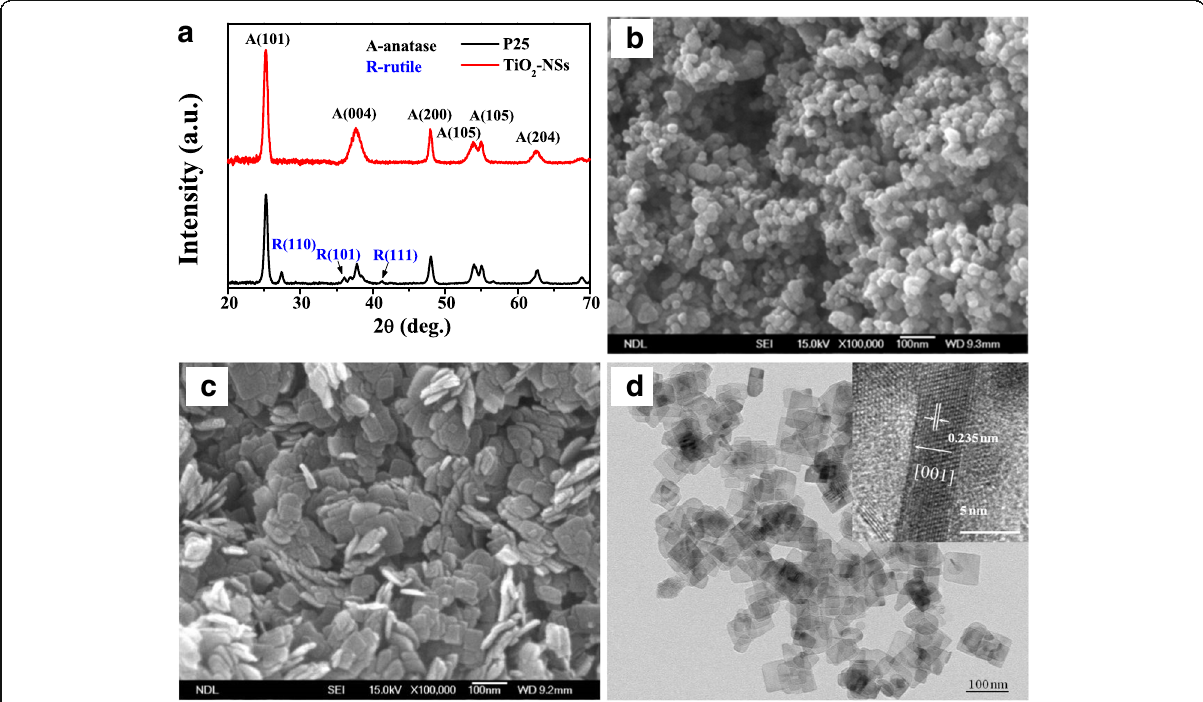
Fig. 1 a XRD patterns of bare TiO 2 NSs and P-25. b , c SEM images of bare TiO 2 NSs and P-25, respectively. d TEM and HRTEM (insert) images of bare